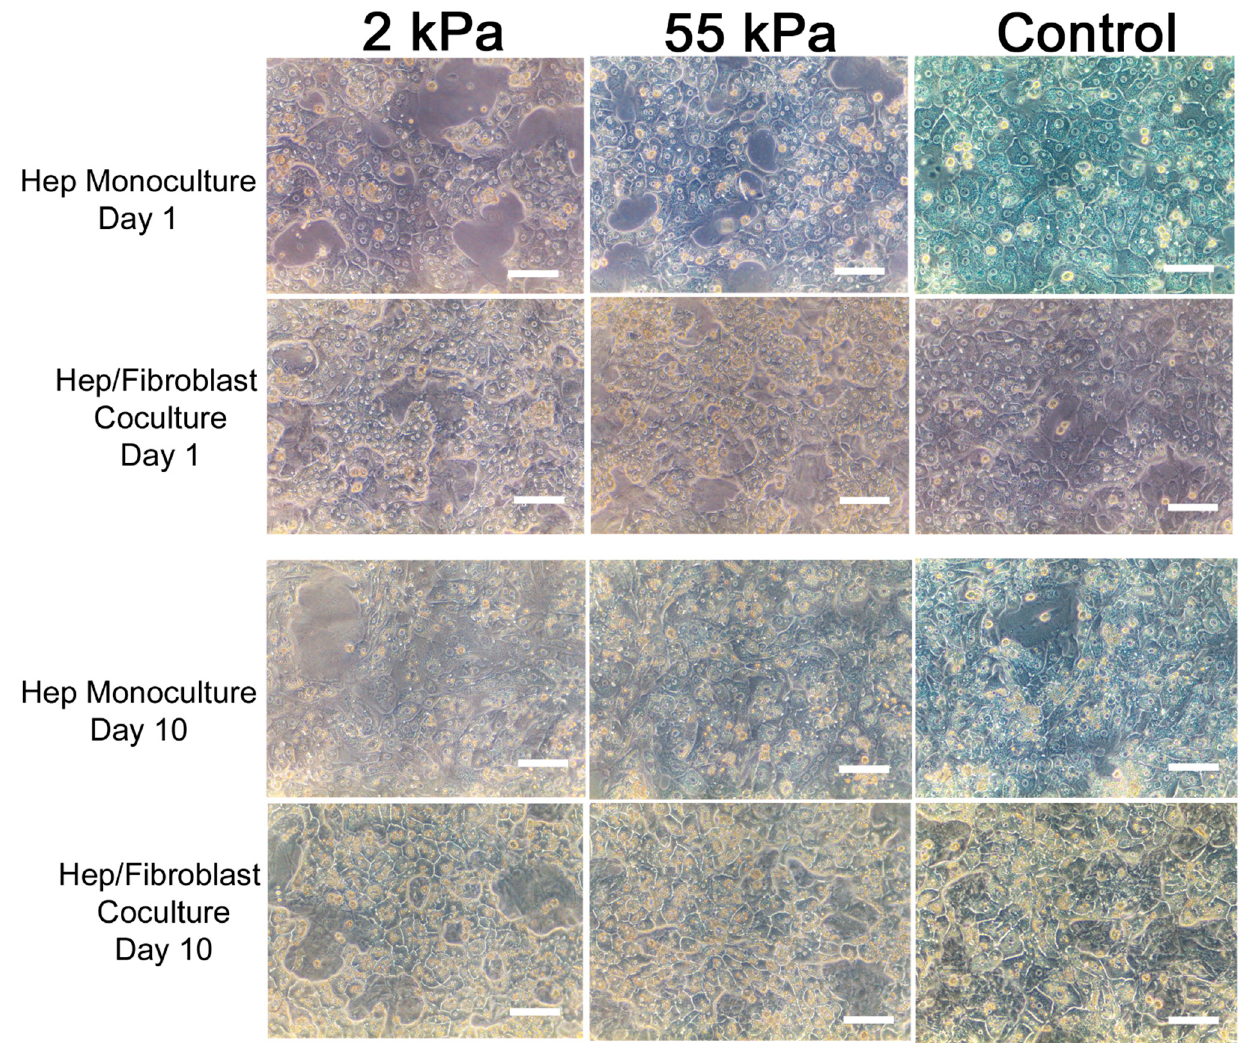
Figure 2. Morphology of primary rat hepatocytes on gels of varying stiffness in the monoculture and coculture. Phase images of hepatocytes cultured on soft (2 kPa), stiff (55 kPa) and TCPS at day 1 and 10. Scale bar = 100 µm.